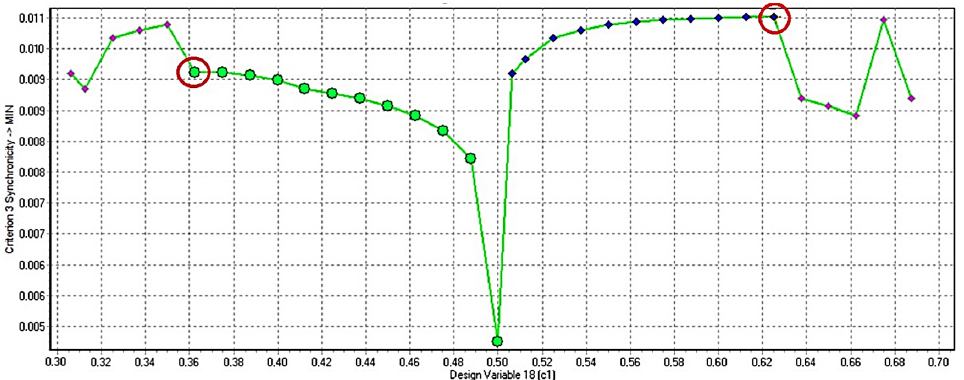
Figure 2. An example of the dependence of the criterion K 3 on the load parameter c 1 . The rest of the parameters are